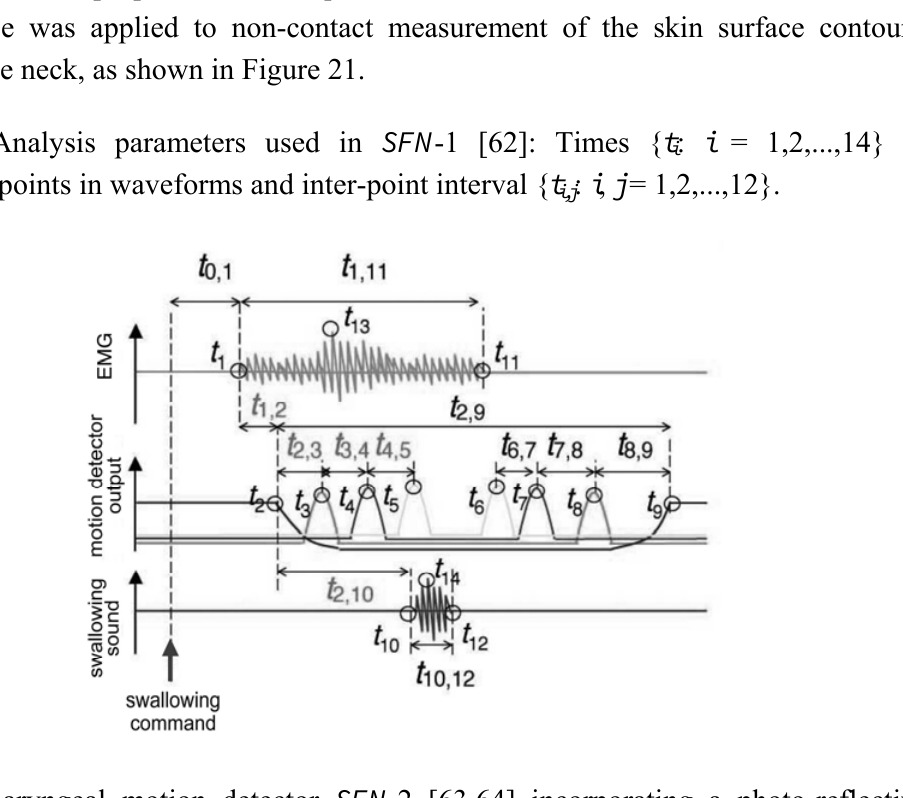
Figure 20. Analysis parameters used in SFN -1 [62]: Times { t characteristic points in waveforms and inter-point interval { t